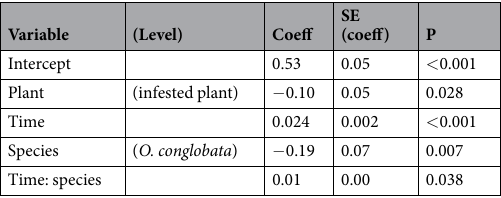
Table 1. Regression coefficients, standard errors and significance for variables retained in the best-fit model describing the relationship between ovarian resorption and (i) plant treatment (clean vs. infested); (ii) time from set-up (0, 6, 12, 24, 48 h); (iii) coccinellid species ( Harmonia axyridis or Oenopia conglobata ); and (iv) interaction between time and coccinellid